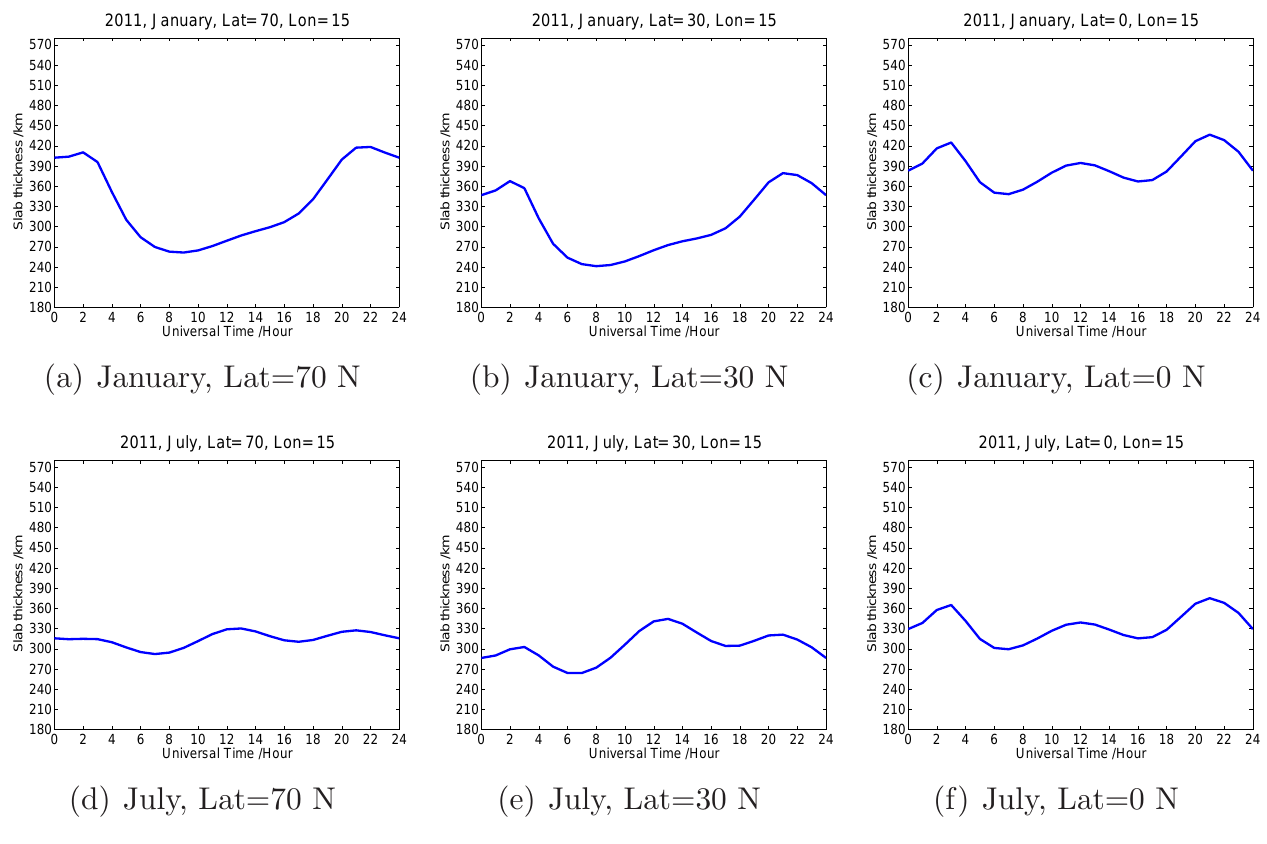
Fig. 3. Variation of slab thickness, Figure 3: Variation of slab thickness, 2011.